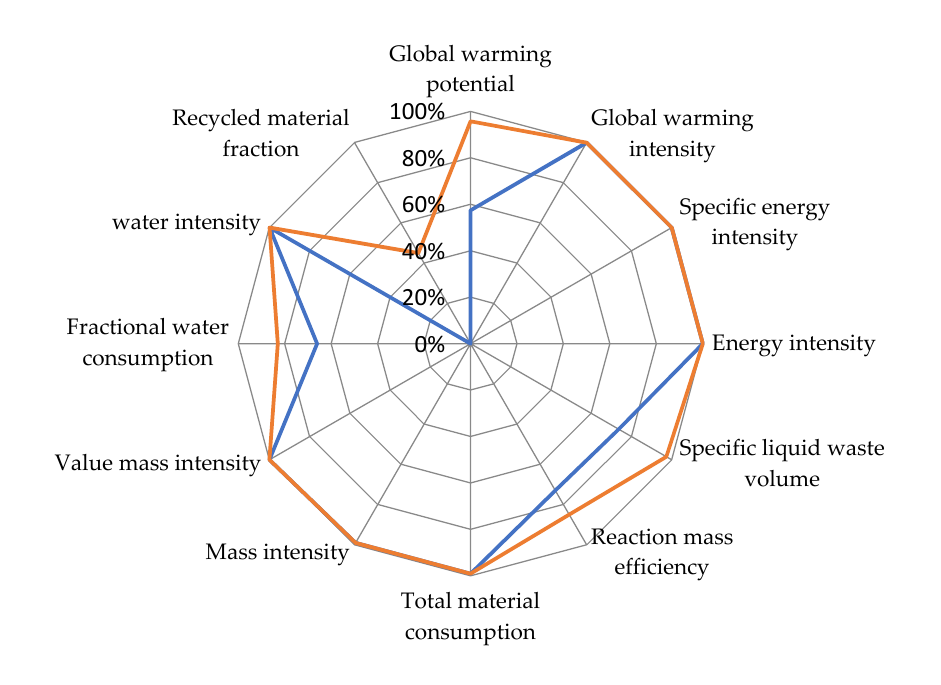
Figure 4. Spider diagram representing the sustainability analysis of the SuperLip process before (blue) and after (orange) optimization.